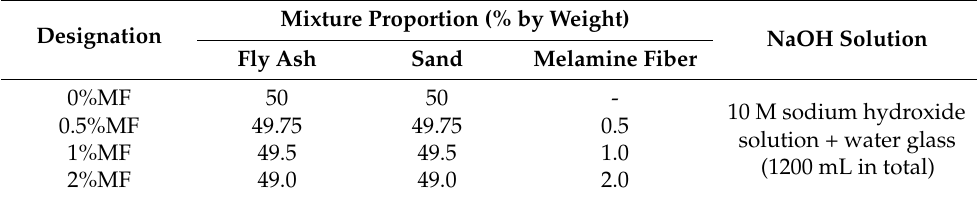
Table 2. Designation of the manufactured composites.